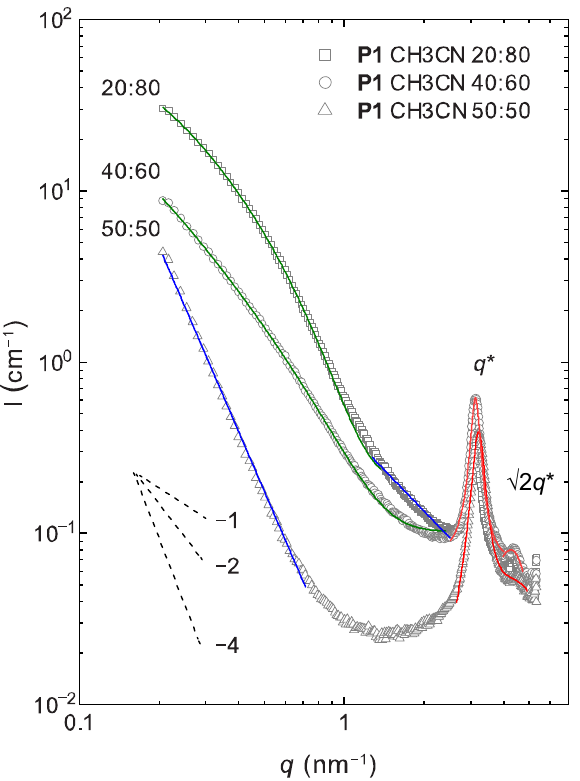
Figure 5. X-ray scattering patterns of polymer 1 in CH 3 CN with polymer: solvent ratios 50:50 (triangles), 40:60 (circles), and 20:80 (squares). Blue, green, and red lines are fit to the power-law sections and to the interference maxima. Black dashed lines show q − 1 , q − 2 , and q − 4 slopes for comparison. Table 3. Parameters estimated from the fits to the small-angle X-ray scattering (SAXS) data of pol- ymer 1 in DMSO and CH 3 CN: α is the power-law exponent, ξ sheet and L are the size and thickness